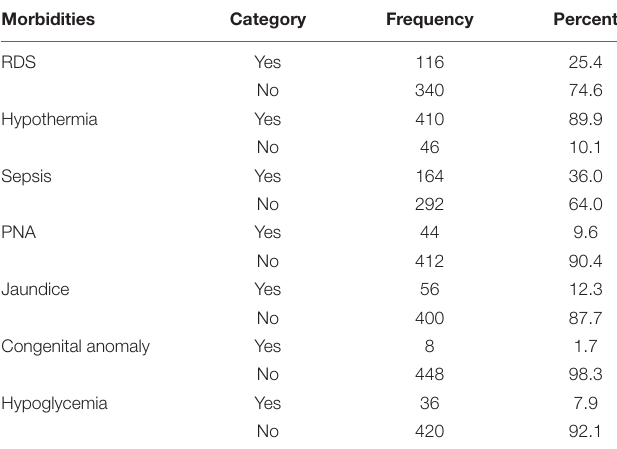
TABLE 4 | Immediate morbidity among preterm neonates in south Gondar zone public hospitals, North West Ethiopia,